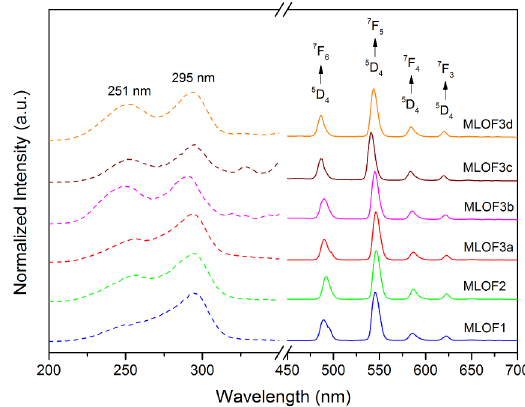
Figure 5. SEM images of MLOF samples; MLOF1 (a), MLOF2 (b), MLOF3a (c), MLOF3d (d), MLOF3c (e), MLOF3b (f).